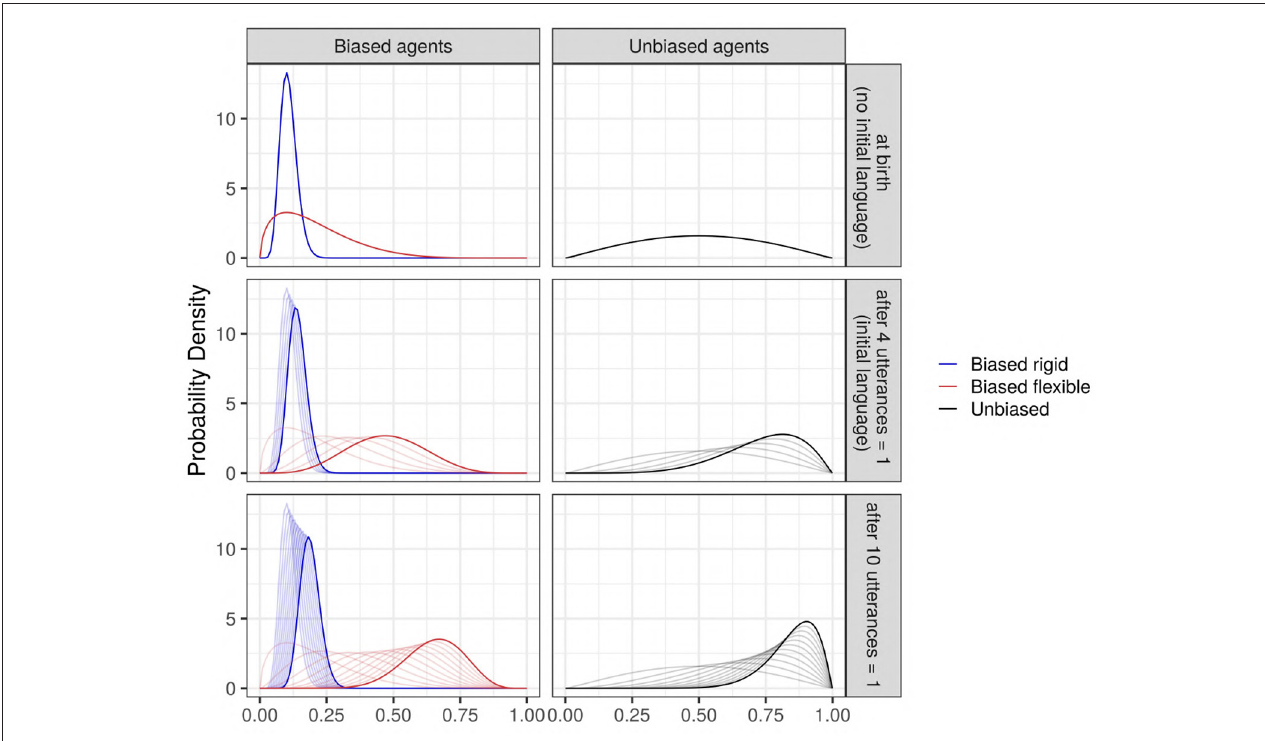
FIGURE 1 | The evolution of some examples of Beta priors (thick solid curves) after seeing some data (utterances), to become successive Beta posterior distributions (thin curves). Blue: an agent strongly biased against the feature; red: an agent weakly biased against the feature; and black: an unbiased agent. (Top) The prior distributions before seeing any data (“at birth”), which corresponds to the case where no initial language exists in the society. (Middle) The Beta distributions updated after seeing n = 4 utterances all containing the value “1” (an initial language is present in the society; mildly biased toward “1”); (Bottom) An example to see the evolution of a Beta prior after seeing n = 10 utterances “1.” The evolution of the priors highly depends on the bias’ strength: it is very fast for weak bias, and slower for strong